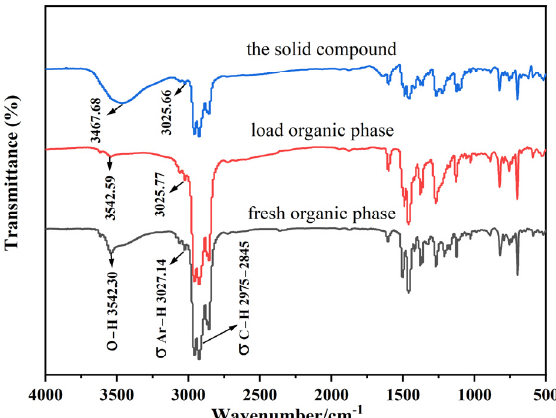
Figure 8. Infrared spectra of the organic phase, loaded organic phase, and solid compound.